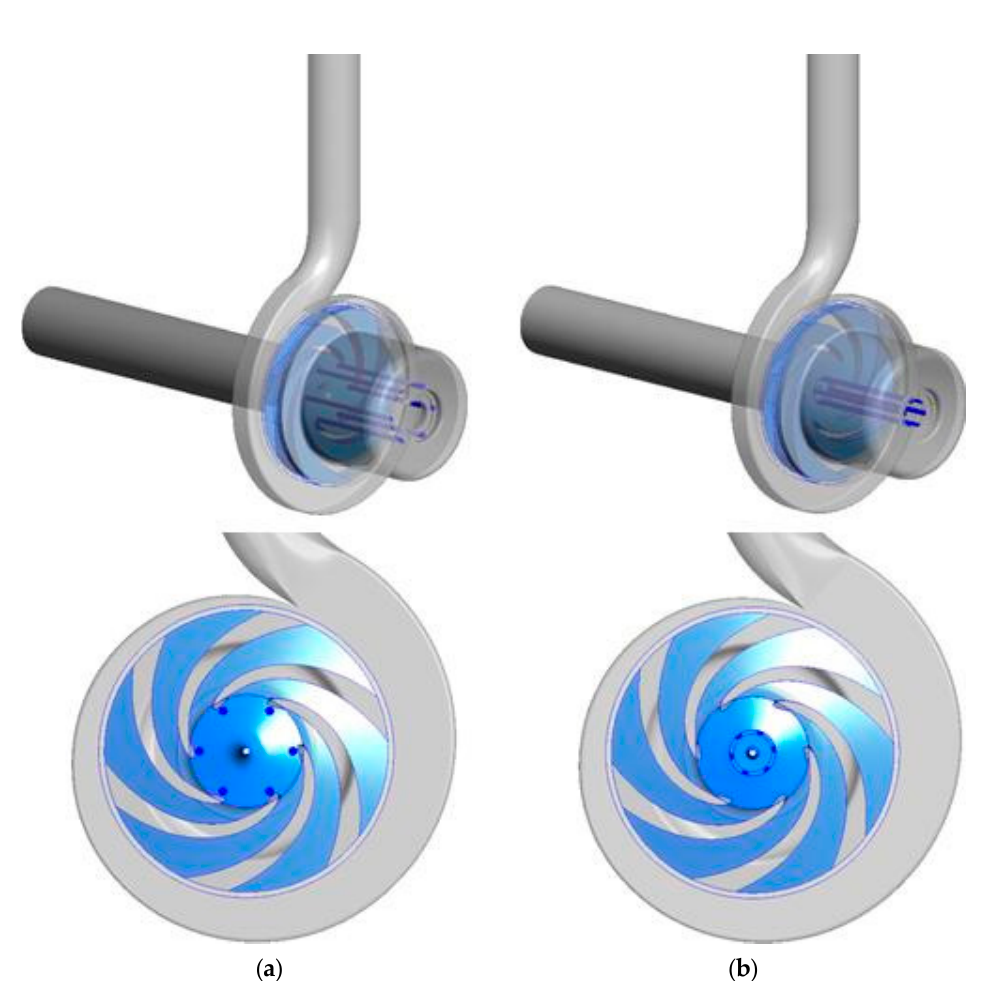
Figure 3. 3D shapes of the two types of balancing holes: ( a ) Type A pump with balancing holes in the impeller; ( b ) Type B pump with balancing holes in the outer wall of the inner shaft.